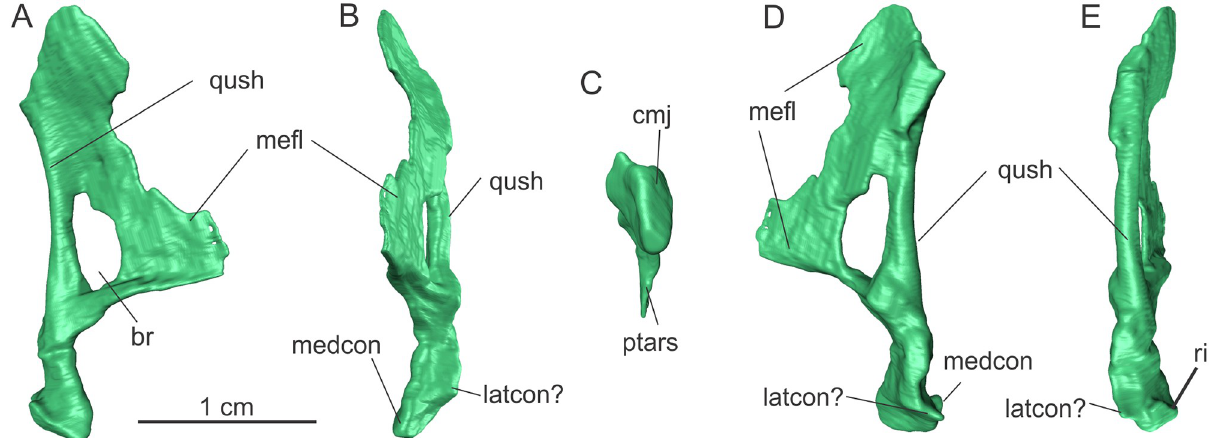
Fig 8. Left quadrate of the specimen MCP-3845-PV of Saturnalia tupiniquim in medial (A), anterior (B), ventral (C), lateral (D), and posterior (E) views. Abbreviations : br— breakage; cmj— craniomandibular joint; latcon— lateral condyle; medcon— medial condyle; mefl— medial flange; ptars — articulation surface with the pterygoid; qush— quadrate shaft; ri— ridge.